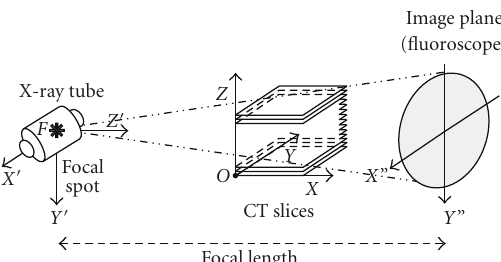
Figure 3: Di ff erent frame of references employed in the study of the 3D pose estimation of the vertebral model. The main frame of reference ( OXYZ ) is related to CT slices and patient. The other frame of reference ( FX (cid:4) Y (cid:4) Z (cid:4) ) is fixed to the DVF device: where F is the X-ray focal spot, x and y axes describe the orientation of the image plane and the z axis represents the direction connecting F with the radiographic image centre (focal length). Orientation of the DVF frame of reference is described by a translation vector (e.g., X , Y , Z in Table 1, which represent the X-ray focal spot coordinates with respect to the CT frame of reference) and the Euler angles ( φ , θ , ϕ rotation angles about the axes x , y and z